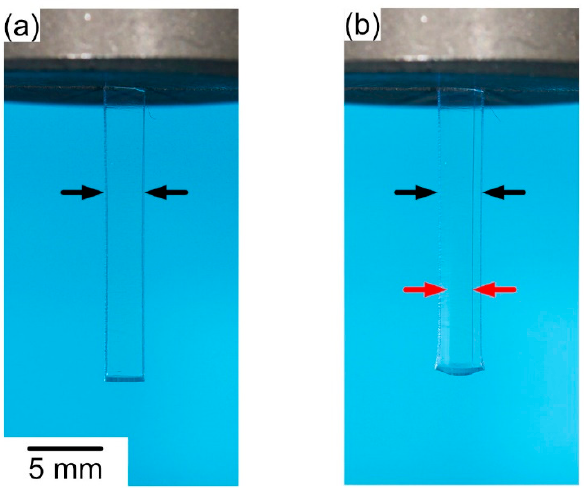
Figure 14. SMP-E (100% programming strain) in acetone. ( a ) Shortly after immersion. ( b ) After 3600 s: sharp diffusion front marked by red arrows. Thickness of diffusion layer: 0.65 mm.